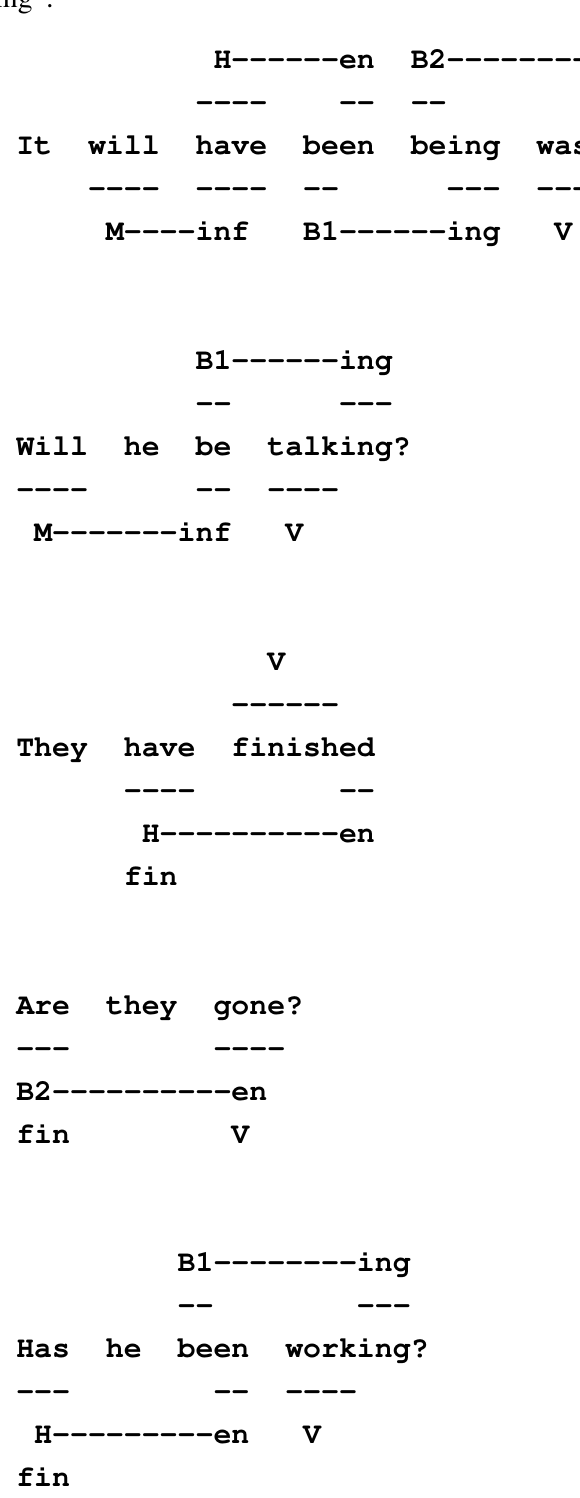
Figure 12. A selection of example sentences in English with markings of dependencies between the verbs. Key: “ M ” = modal, “ H ” = forms of the verb “have”, “ B1 ” = first instance of a form of the verb “be”, “ B2 ” = second instance of a form of the verb “be”, “ V ” = main verb, “ fin ” = a finite form, “ inf ” = an infinitive form, “ en ” = a past tense form, “ ing ” = a verb ending in